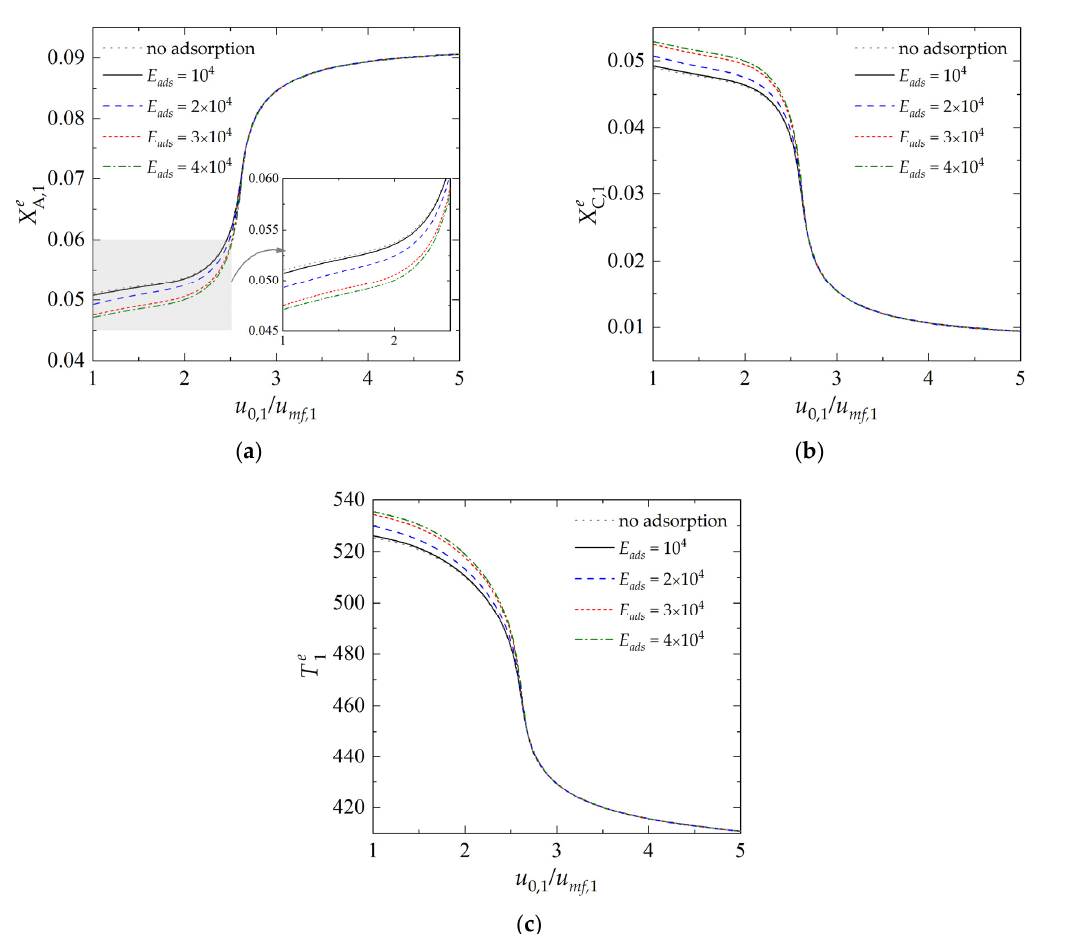
Figure 3. Dependence of state variables in the reactor on the fluidization ratio u 0,1 / u mf ,1 for different values of E ads : ( a ) dimensionless concentration of component A in the emulsion (dense) zone; ( b ) dimensionless concentration of component C in the emulsion zone; ( c ) temperature of the emulsion zone. (Calculations performed with Δ s = − 150 kJ·kmol − 1 ·K − 1 , u 0,2 / u mf ,2 = 2, τ p ,1 = τ p ,2 = 600 s and T f, 2 = 400 K; all values of E ads in the legend are expressed in kJ·kmol − 1 ).